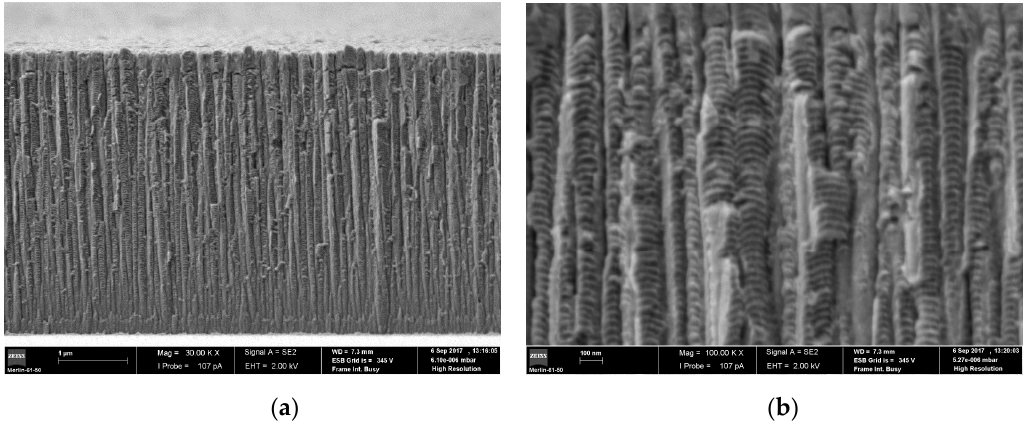
Figure 2. Cross-section images (SEM) of a Ni/Al multilayer thin film deposited onto Si substrate at different magnifications. ( a ) 30,000× and ( b ) 100,000×.